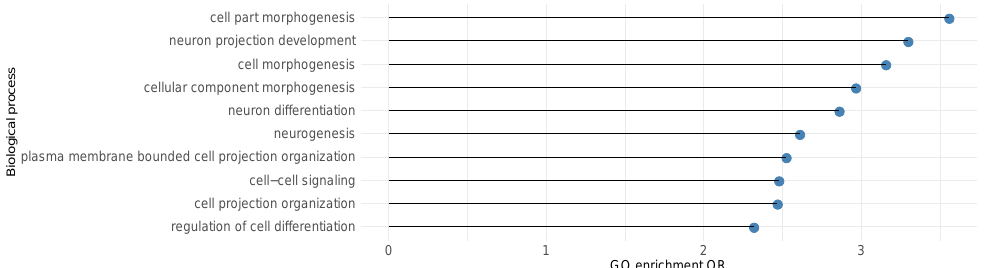
Figure 7. ASD gene ontology(GO) enrichement analysis results for top 10 biological processes with FDR ≤ 0.05. Enrichment of biological processes including cell part morphogenesis (OR = 3.56), neuron projection development (OR = 3.29), and neuron differentiation (OR = 2.86) were discovered at FDR = 0.1, consistent with current knowledge on